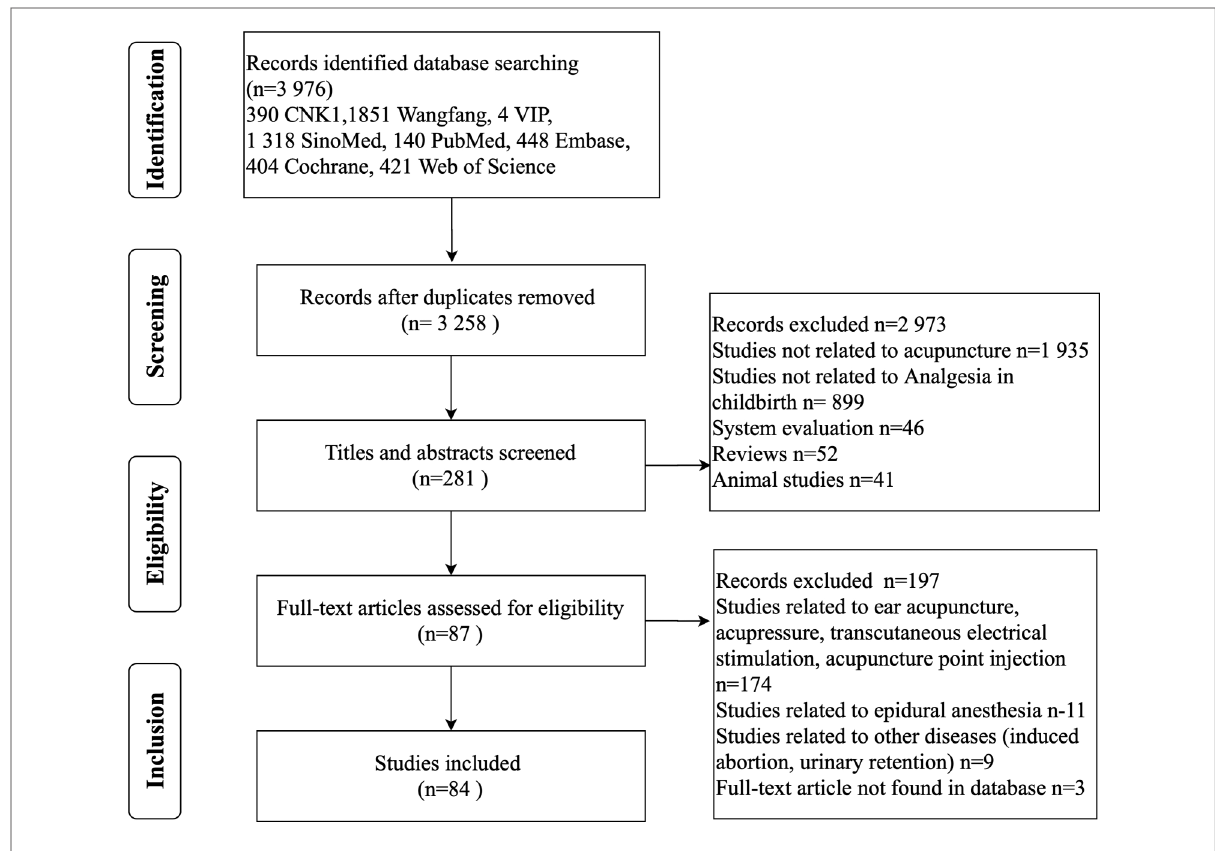
FIGURE 1 Process and results of literature